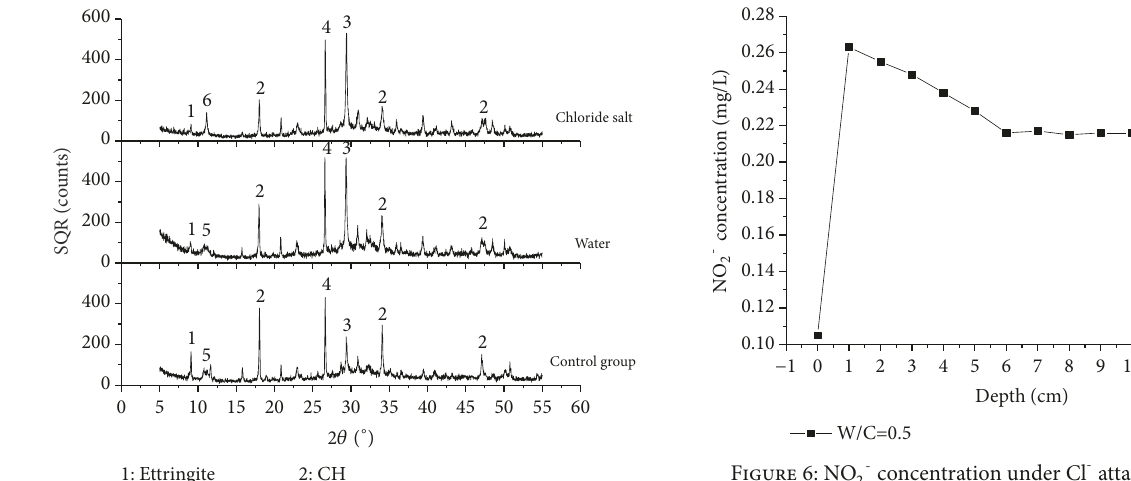
Figure 6: NO 2 - concentration under Cl - attack